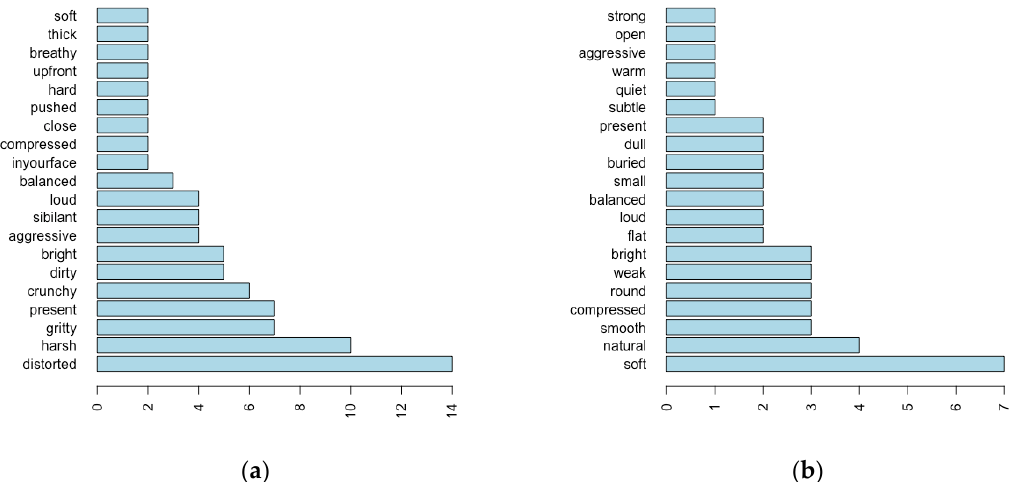
Figure 7. ( a ) Descriptors used for the Universal Audio 1176 (1176) compressor; ( b ) descriptors used for the clean software compressor measured to have 0% THD. Descriptors for both ratios and all three songs have been combined for both compressors.